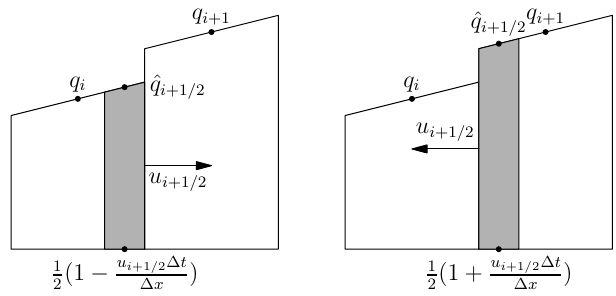
Figure 1. Van Leer scheme for positive (left) and negative (right) winds. The distribution of the tracer is shown as a linear distribution (broken line). The grey area is the quantity of tracer passing through the interface during a time